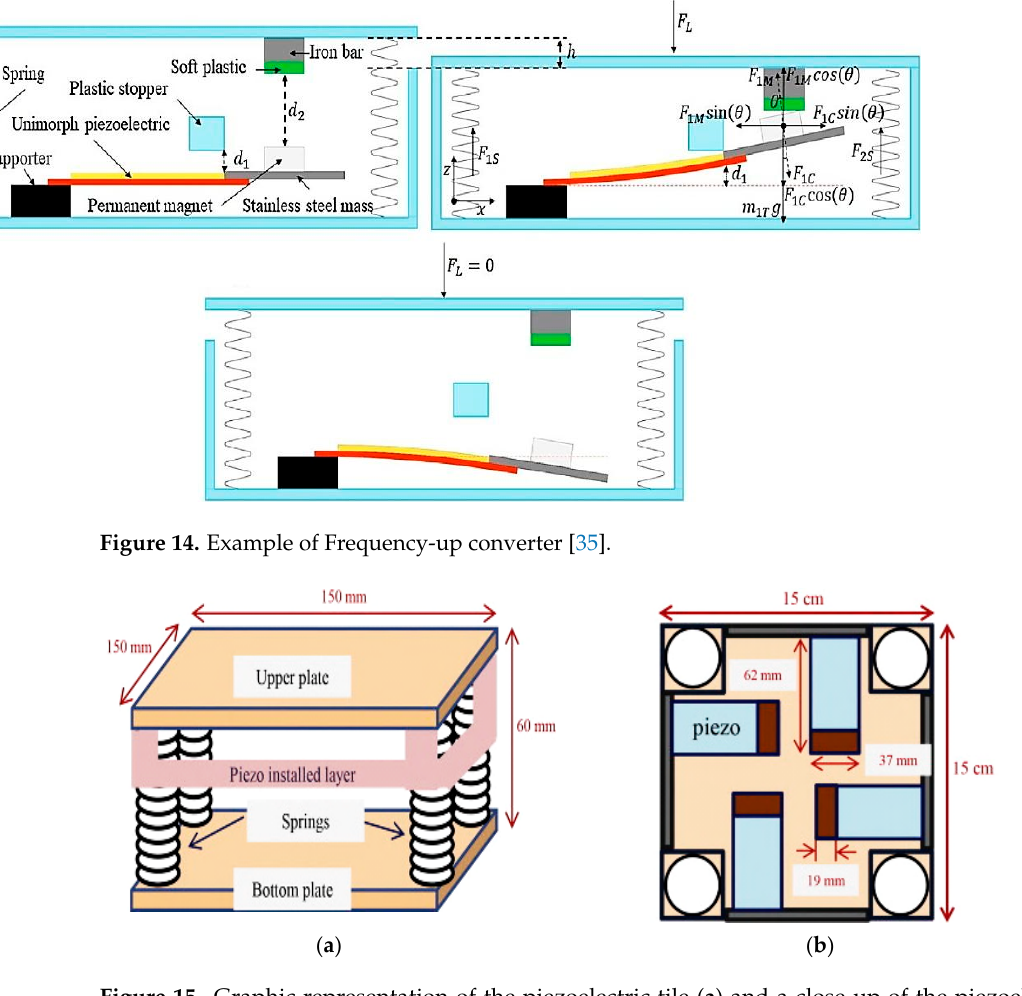
Figure 14. Example of Frequency-up converter [35].